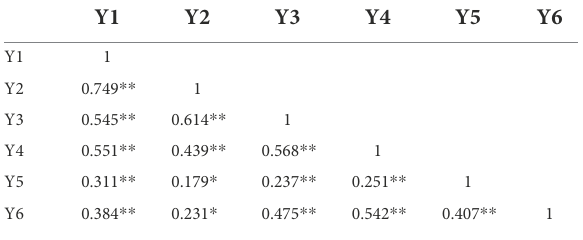
TABLE 7 Correlation results within comprehension of conversational implicature types.